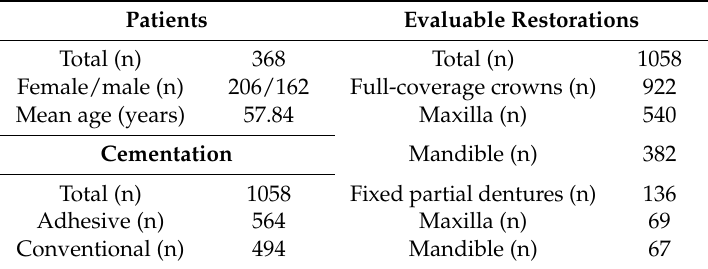
Table 2. Patient demographics, restoration types and cementation